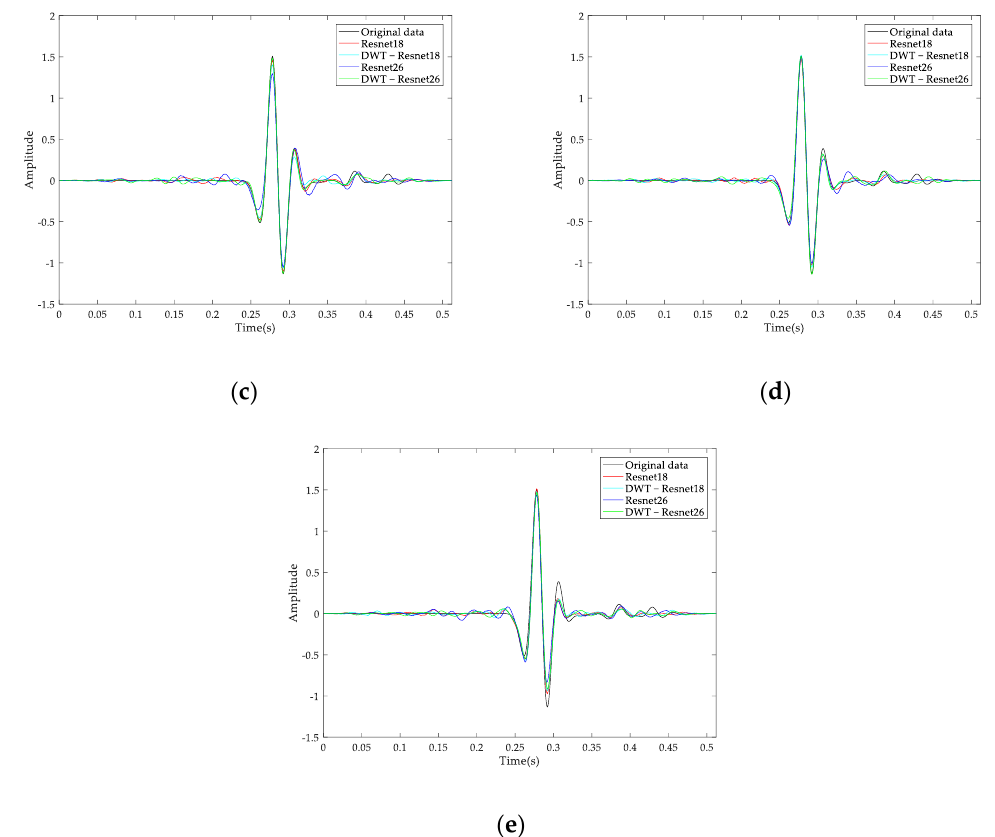
Figure 6. ( a – e ) illustrates the single−channel data compared with the clean single−channel data after denoising with four denoising methods at SNR ranked from high to low.